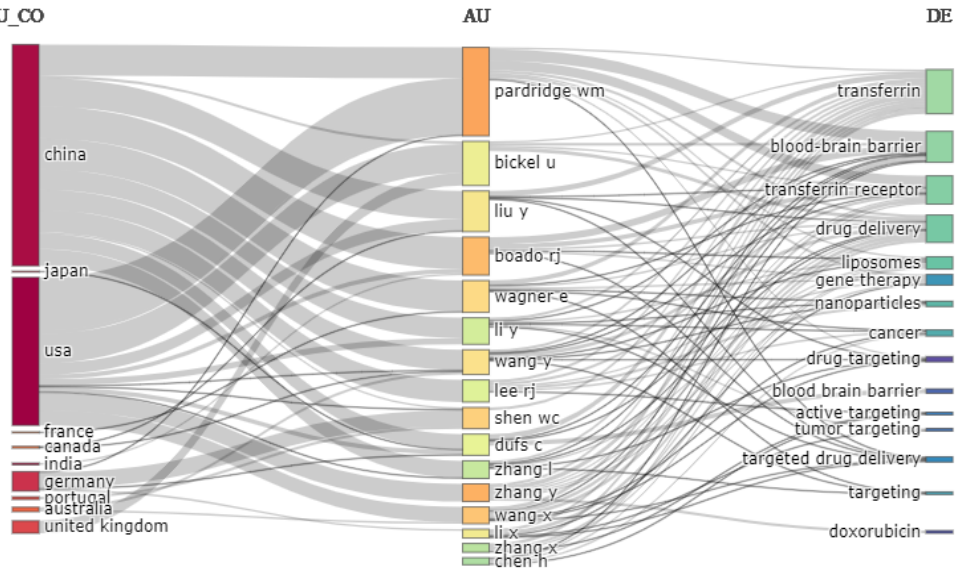
Figure 11. Three-field plot. Source: Authors’ elaboration using the Bibliometrix R-package.